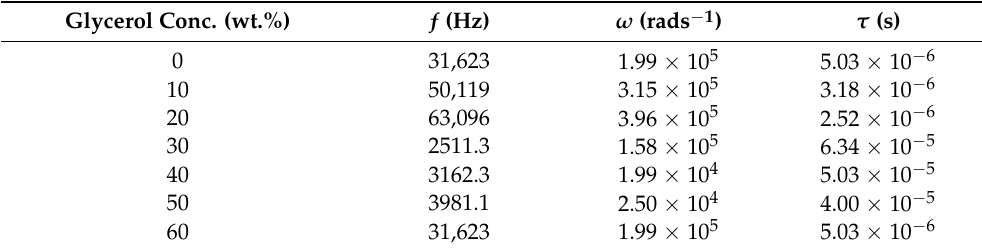
Table 2. Relaxation time of various concentrations of glycerol-plasticized SPEs. Glycerol Conc.